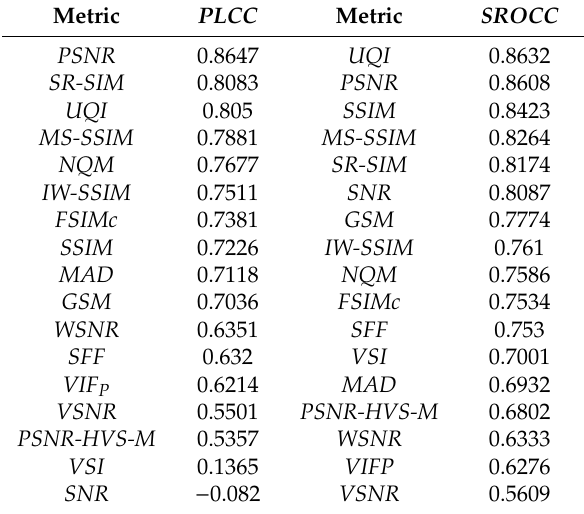
Table 9. The overall correlation between subjective MOS scores and FR-IQA